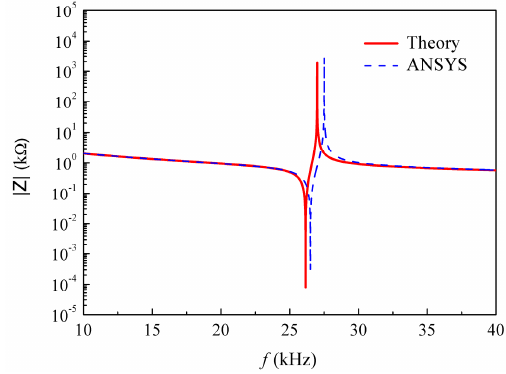
Figure 3. Theoretical and simulated impedance spectra. Table 3. Comparisons between the calculated, simulated and experimental frequencies.